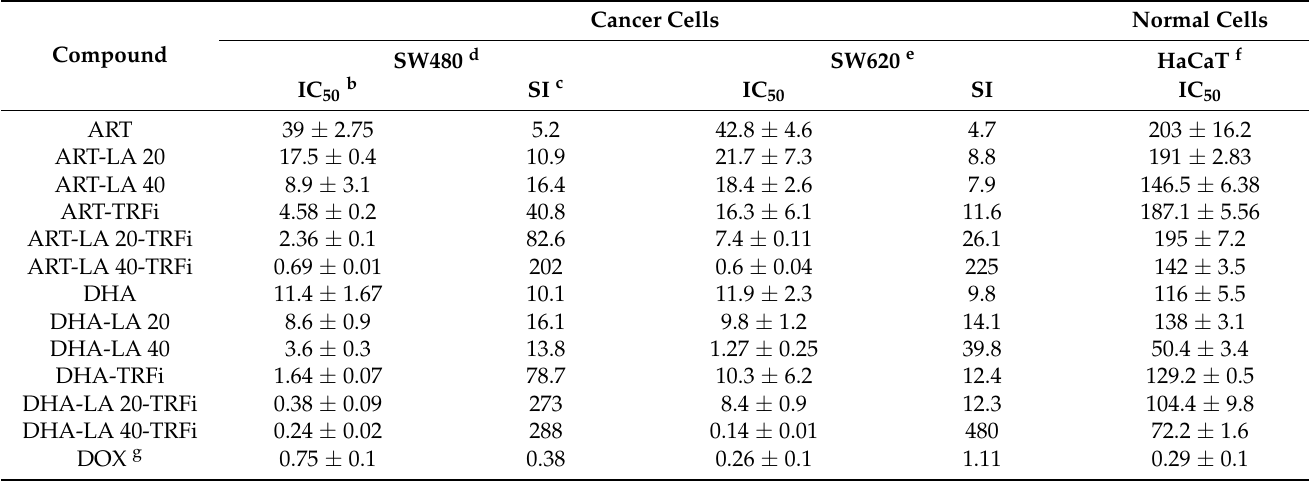
a Data are expressed as mean ± SD. b IC 50 ( µ M)—the concentration of the compound that corresponds to a 50% growth inhibition of cell line (as compared to the control) after culturing the cells for 72 h with the studied compound. c The SI (selectivity index) was calculated using the formula: SI = IC 50 for normal cell line/IC 50 for cancer cell line. d Human primary colon cancer cell line (SW480), e human metastatic colon cancer cell line (SW620), f human immortal keratinocyte cell line from adult human skin (HaCaT), and g the selected reference compound commonly used in cancer treatment